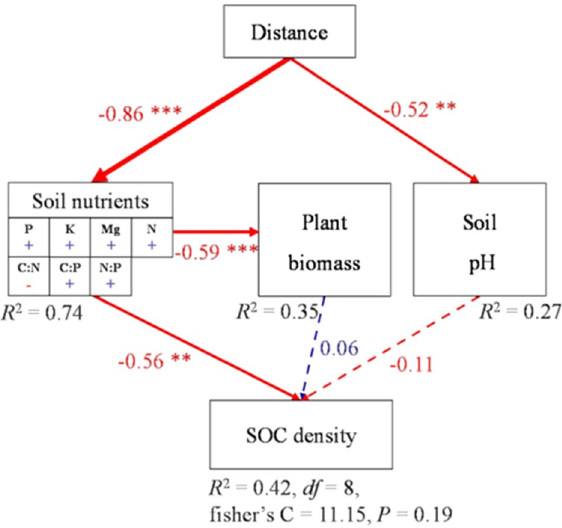
Figure 5. The construction of the best structure equation model (SEM), reveals the influence of various factors on soil organic carbon density (SOCD, kg·m −2 ). It is concluded that offshore distance further affects the change of SOCD through the inhibition of other factors (soil factor, biomass and soil